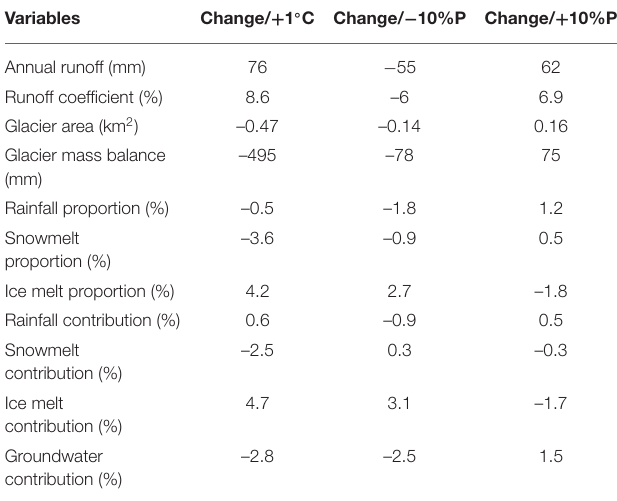
TABLE 1 | Sensitivities of hydrological variables to precipitation and temperature